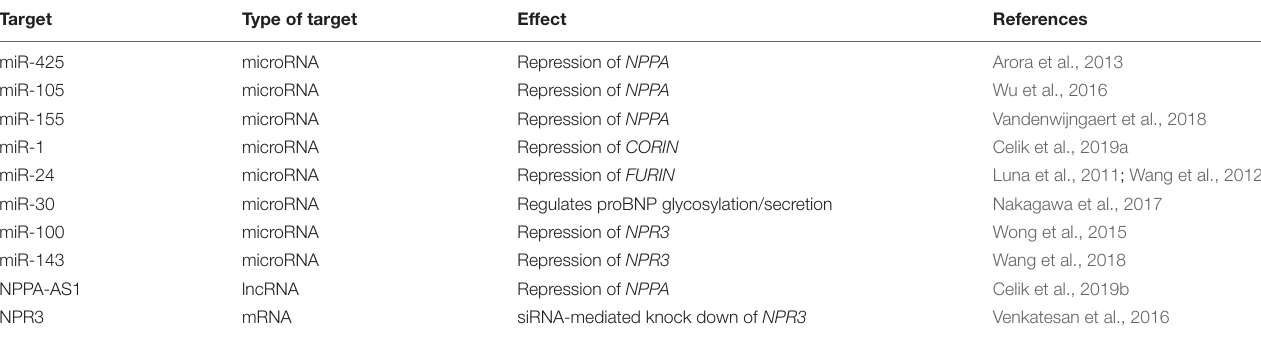
TABLE 3 | Putative targets for RNA-based augmentation of the NP